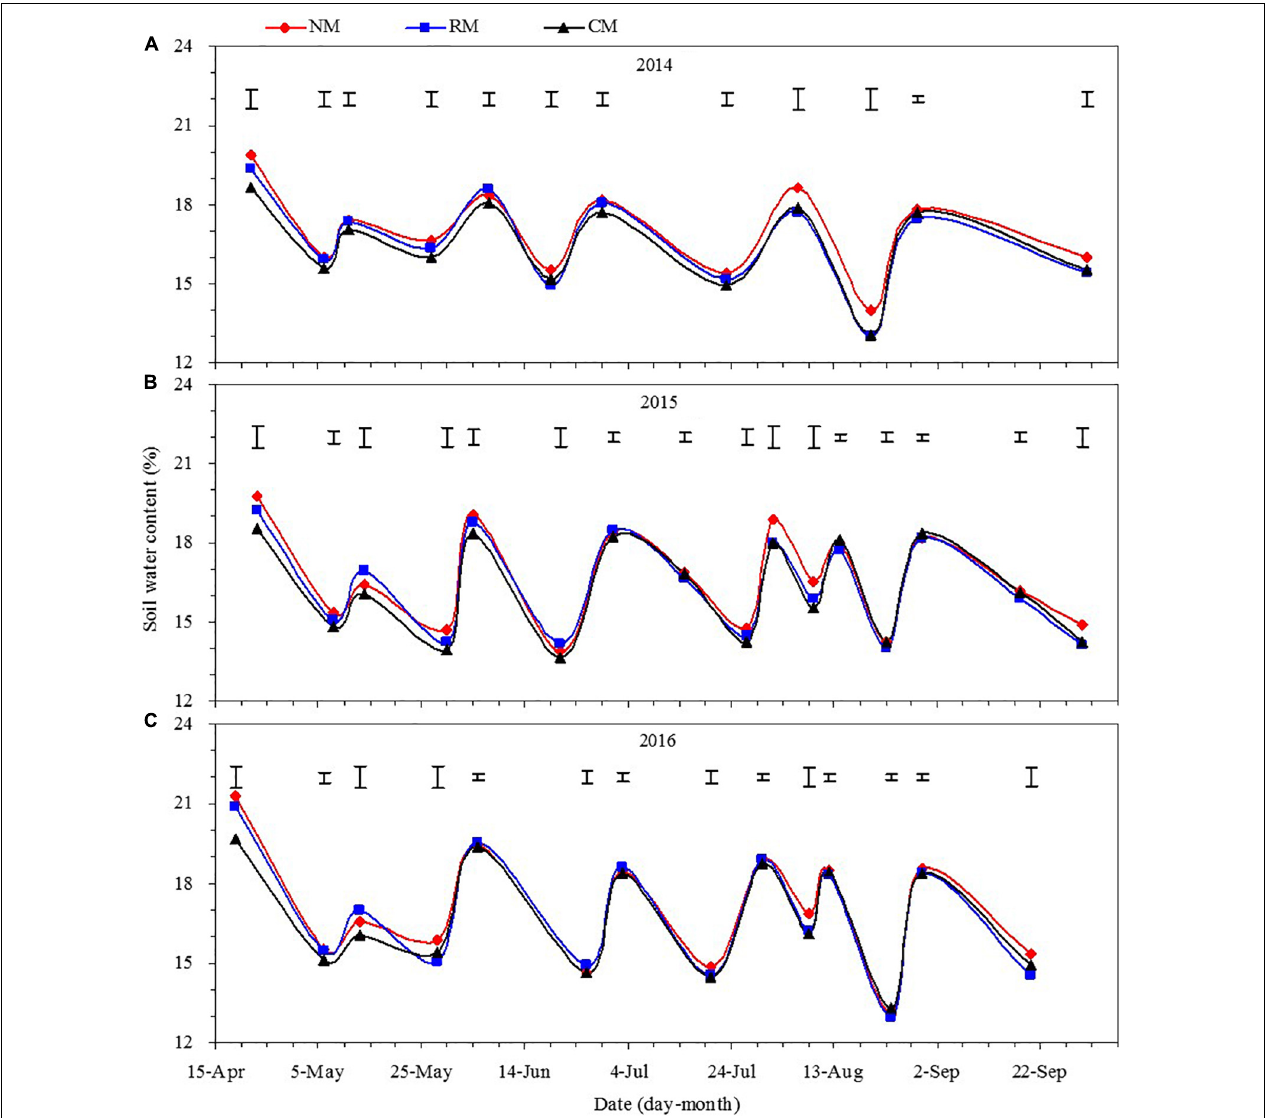
FIGURE 5 | Dynamics of soil water content in the 0–120 cm soil layer in maize field as affected by plastic mulching practices across the entire growing season in 2014 (A) , 2015 (B) , and 2016 (C) . NM, no tillage with plastic re-mulching; RM, no tillage with plastic mulching after maize was harvested in autumn and new plastic was mulched in next spring after the old plastic was removed off the field and rotary ploughed; CM, conventional deep tillage (the depth is 30 cm) after maize was harvested and the old plastic was removed off the field in autumn, and new plastic was mulched in next spring before maize sowing. The length of vertical bars represents the magnitude of the least significant difference (LSD) at P = 0.05 among treatments within a measurement date. NS, no significant difference at the 0.05 probability